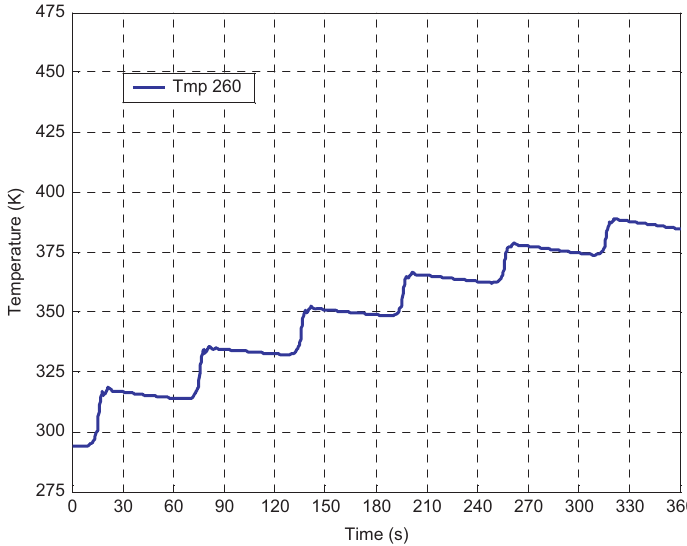
Figure 9 Temperature distribution at node 260 (representing fi rst